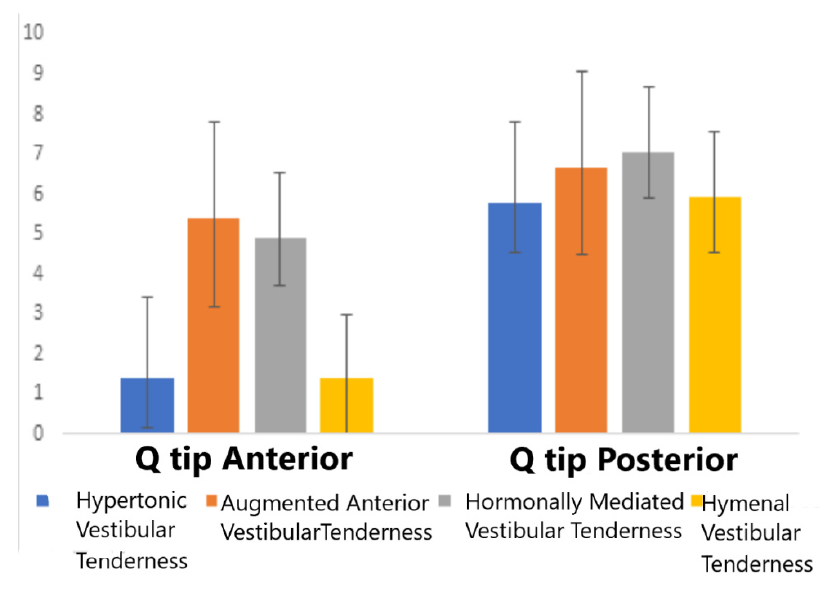
Figure 4. Group comparison of pain intensity scores obtained by Q-tip stimulation at the anterior and posterior vestibule in the four subgroups.